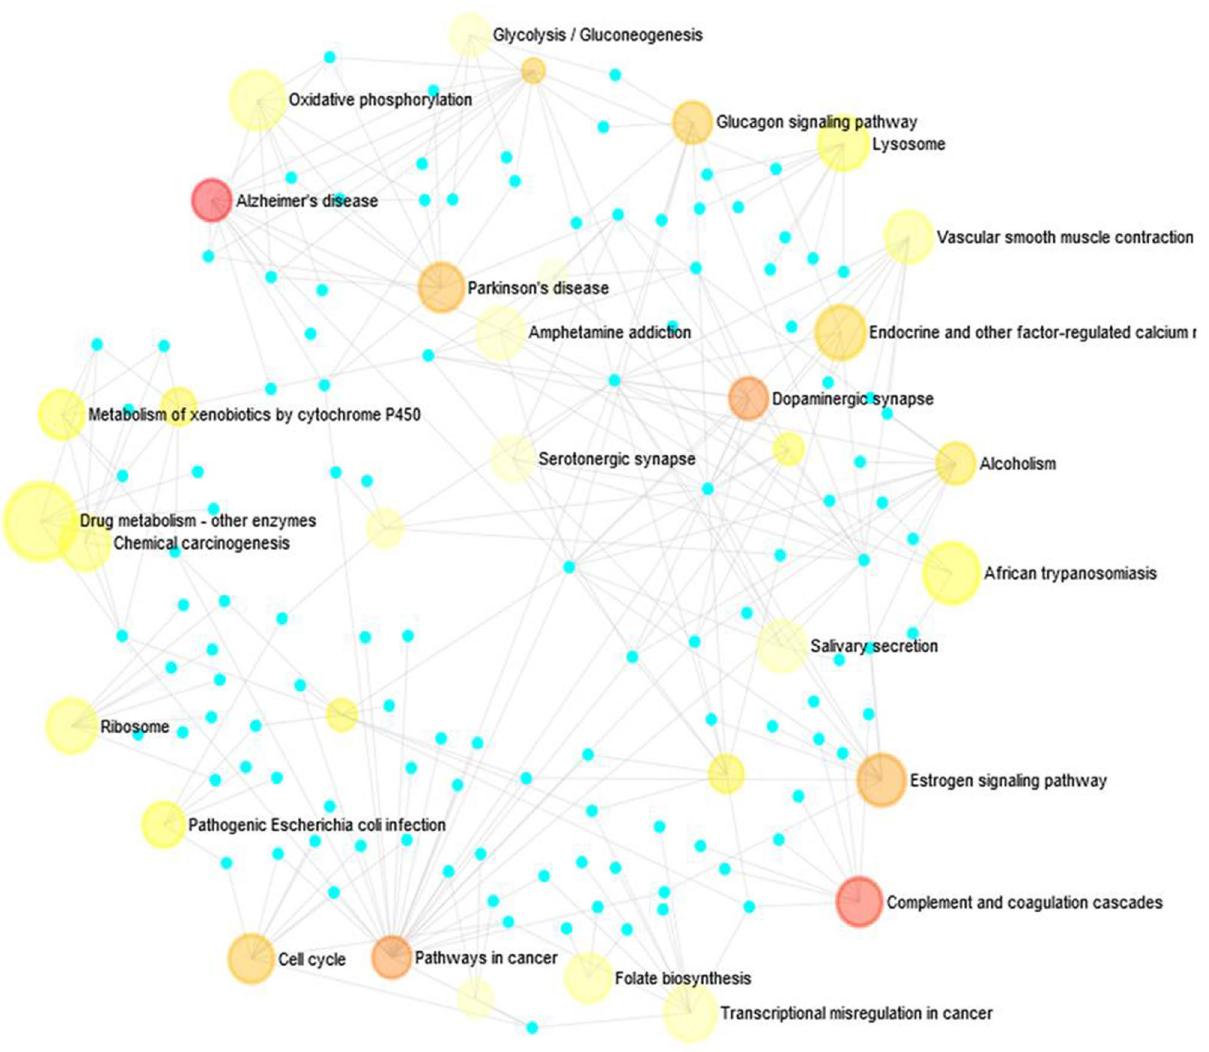
Figure 3. Enrichment network analysis observed through Network Analyst tool representing the pathways involved in differentially expressed